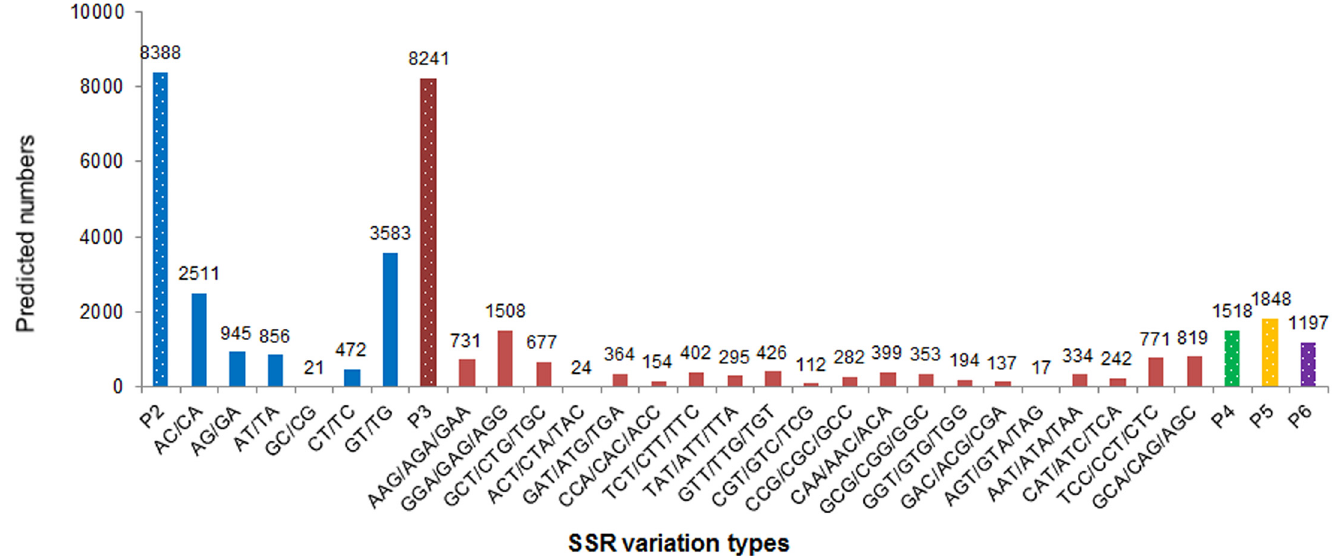
Fig 6. Frequency distribution of SSRs by motif length found in Scophthalmus maximus .